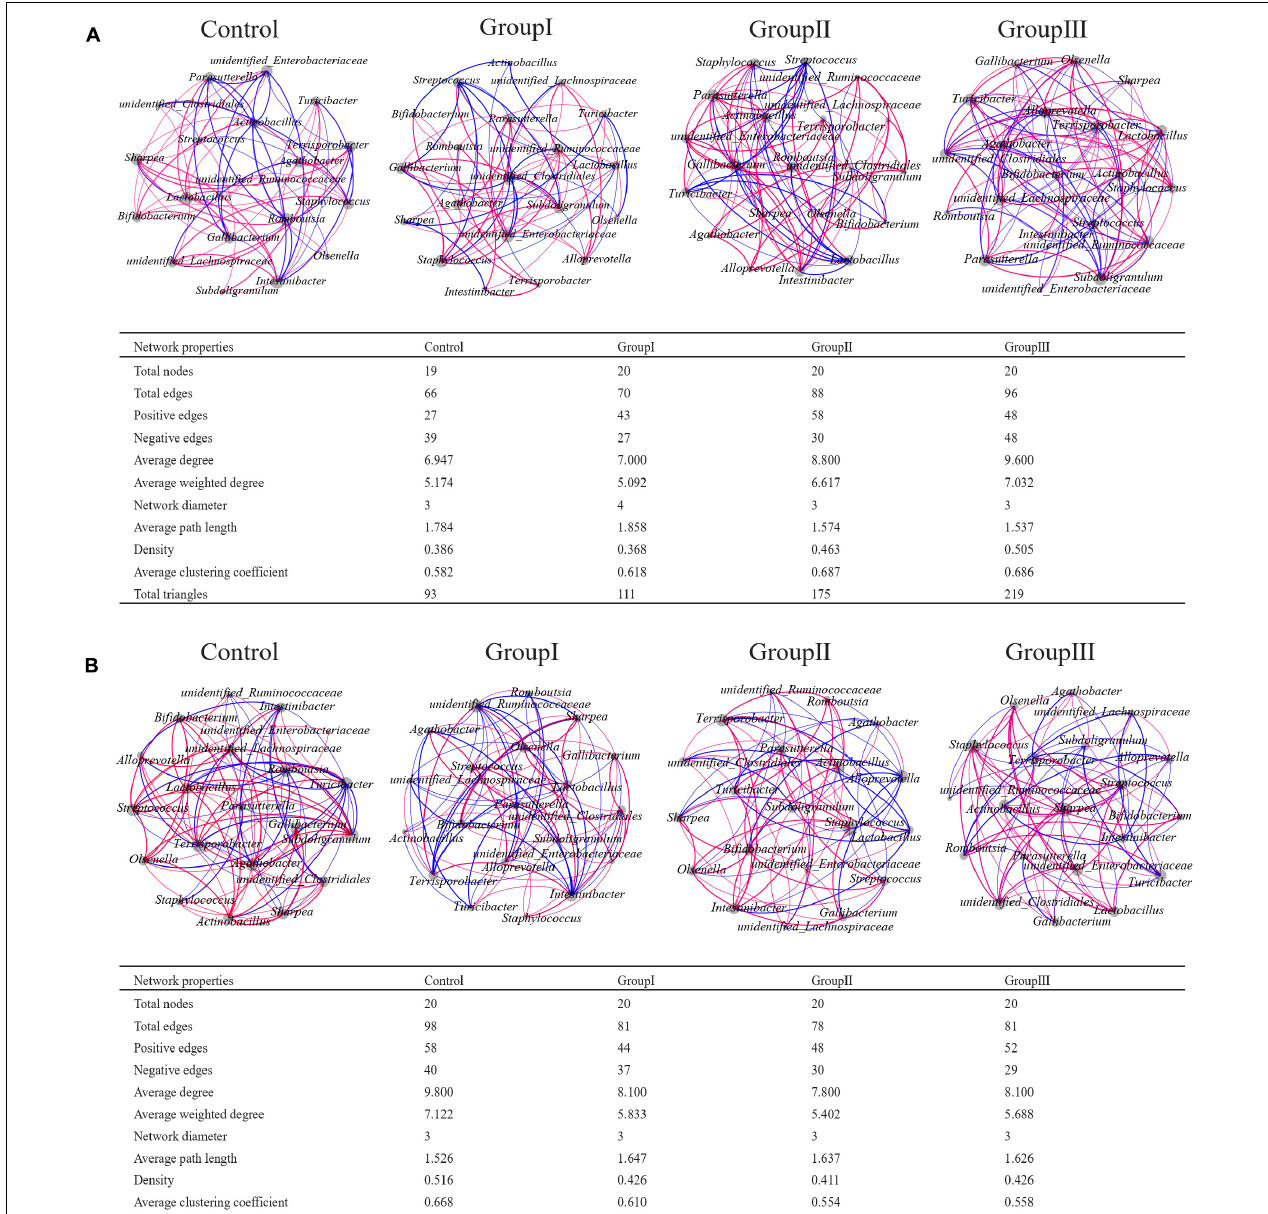
FIGURE 5 | Co-occurrence networks of the 20 most abundant genera from the four dietary fiber groups in jejunal (A) and cecal (B) contents. Each line (blue: negative; red: positive) represents a Spearman’s correlation greater than +0.5 or lower than −